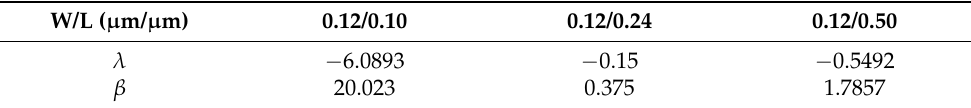
Figure 9. I DS vs. V DS with W / L =0.12/0.10 ( µ m/ µ m): ( a ) single-fin and ( b ) multi-fin. Table 1. Extracted parameters for λ and β values under V DS = 1.2 V and V GS - V T = 0.1~0.3 V with single-fin.